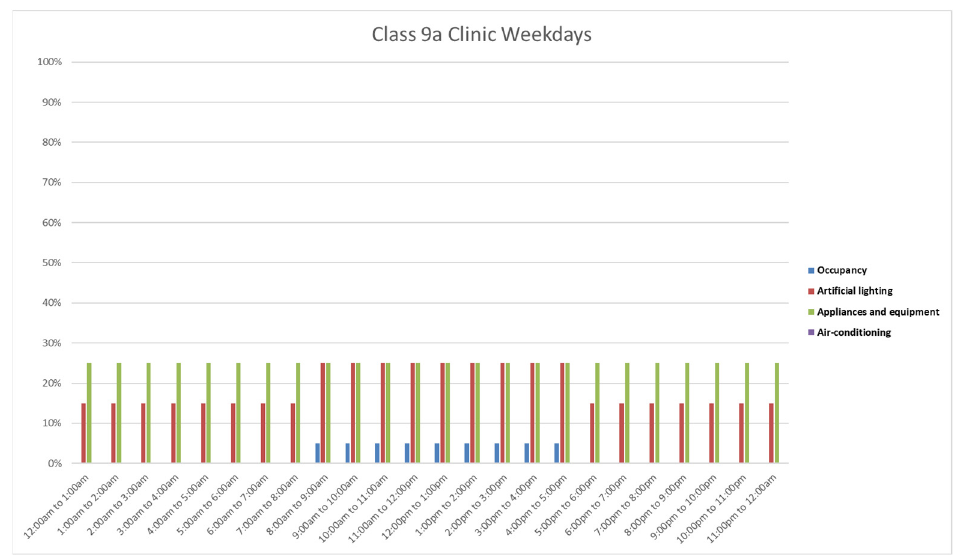
Figure 7. Operation schedules for “Class 9a Clinic”—weekends.